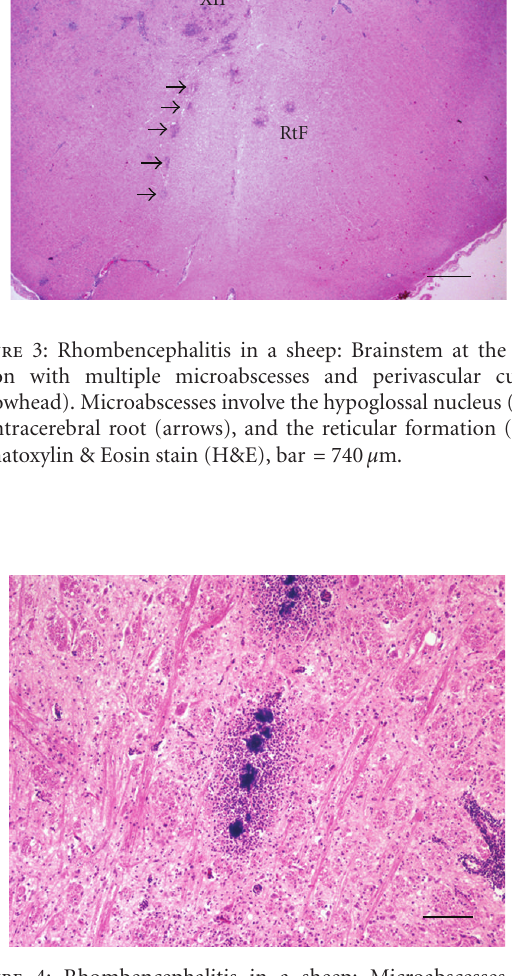
Figure 4: Rhombencephalitis in a sheep: Microabscesses with central bacterial colonies aligned along an axonal tract within the reticular formation (medulla oblongata). H&E, bar = 100 μ